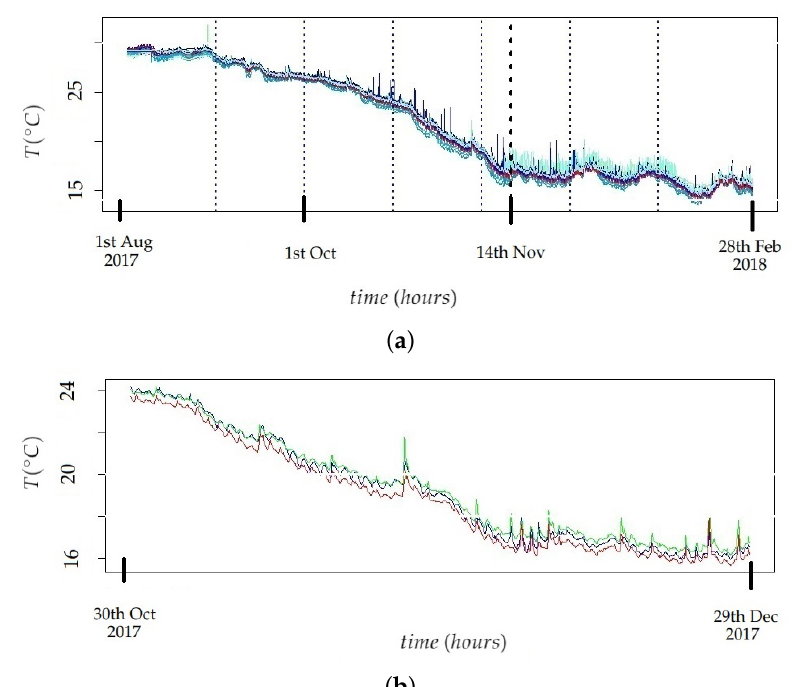
Figure 5. ( a ) Trajectories of temperature for the 21 nodes, before subtracting their corresponding sensor bias. The thick vertical dotted line (November 14th) indicates a change of trend: T slowly decreases before this date on average while, next, the mean T is rather constant. Each thin vertical dotted line separates two consecutive stages (months) that were considered to split the different time series of T. In total, seven stages were considered. ( b ) Trajectories of temperature (before subtracting their corresponding sensor bias) for the nodes B (in blue), H (in green), and M (in red) corresponding to the period between October 30th 2017 and December 29th